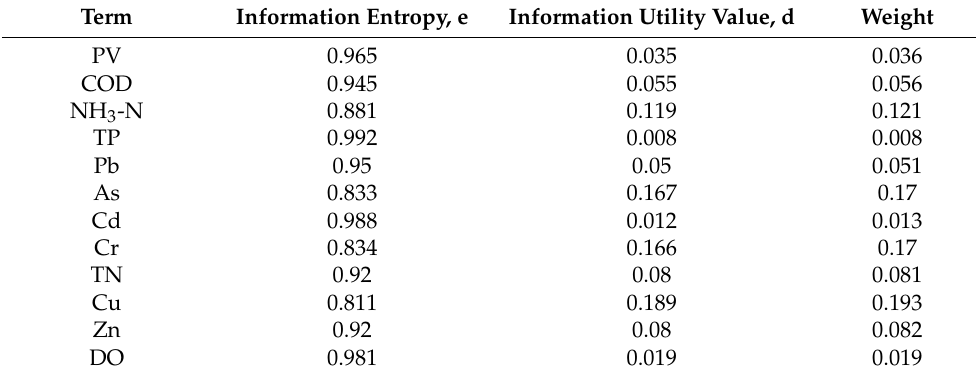
Table 4. Results of weight calculation using the entropy